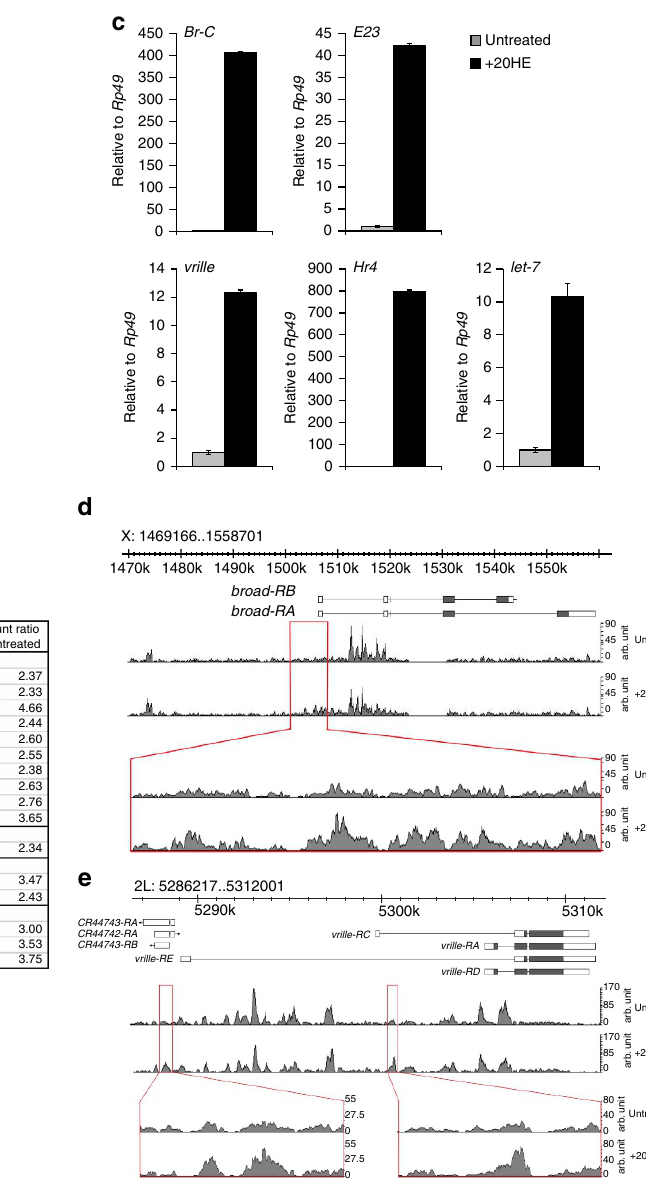
hormone 2–4 , we also analysed the transcript levels of ecdysone- regulated genes in RNAi-treated cells before ecdysone was added (Fig. 2e). In addition to Br-C and vrille , we also included in the analysis Hr4 , E23 , let-7 and two overlapping noncoding RNAs that are transcribed from different strands within an EIMR-containing region upstream of the vrille RE promoter ( CR44743 and CR44742 ; Fig. 1e). As expected, depletion of EcR resulted in the derepre- ssion of the majority of genes tested (1.5-fold to 20-fold). By NATURE COMMUNICATIONS|8:14806|DOI: